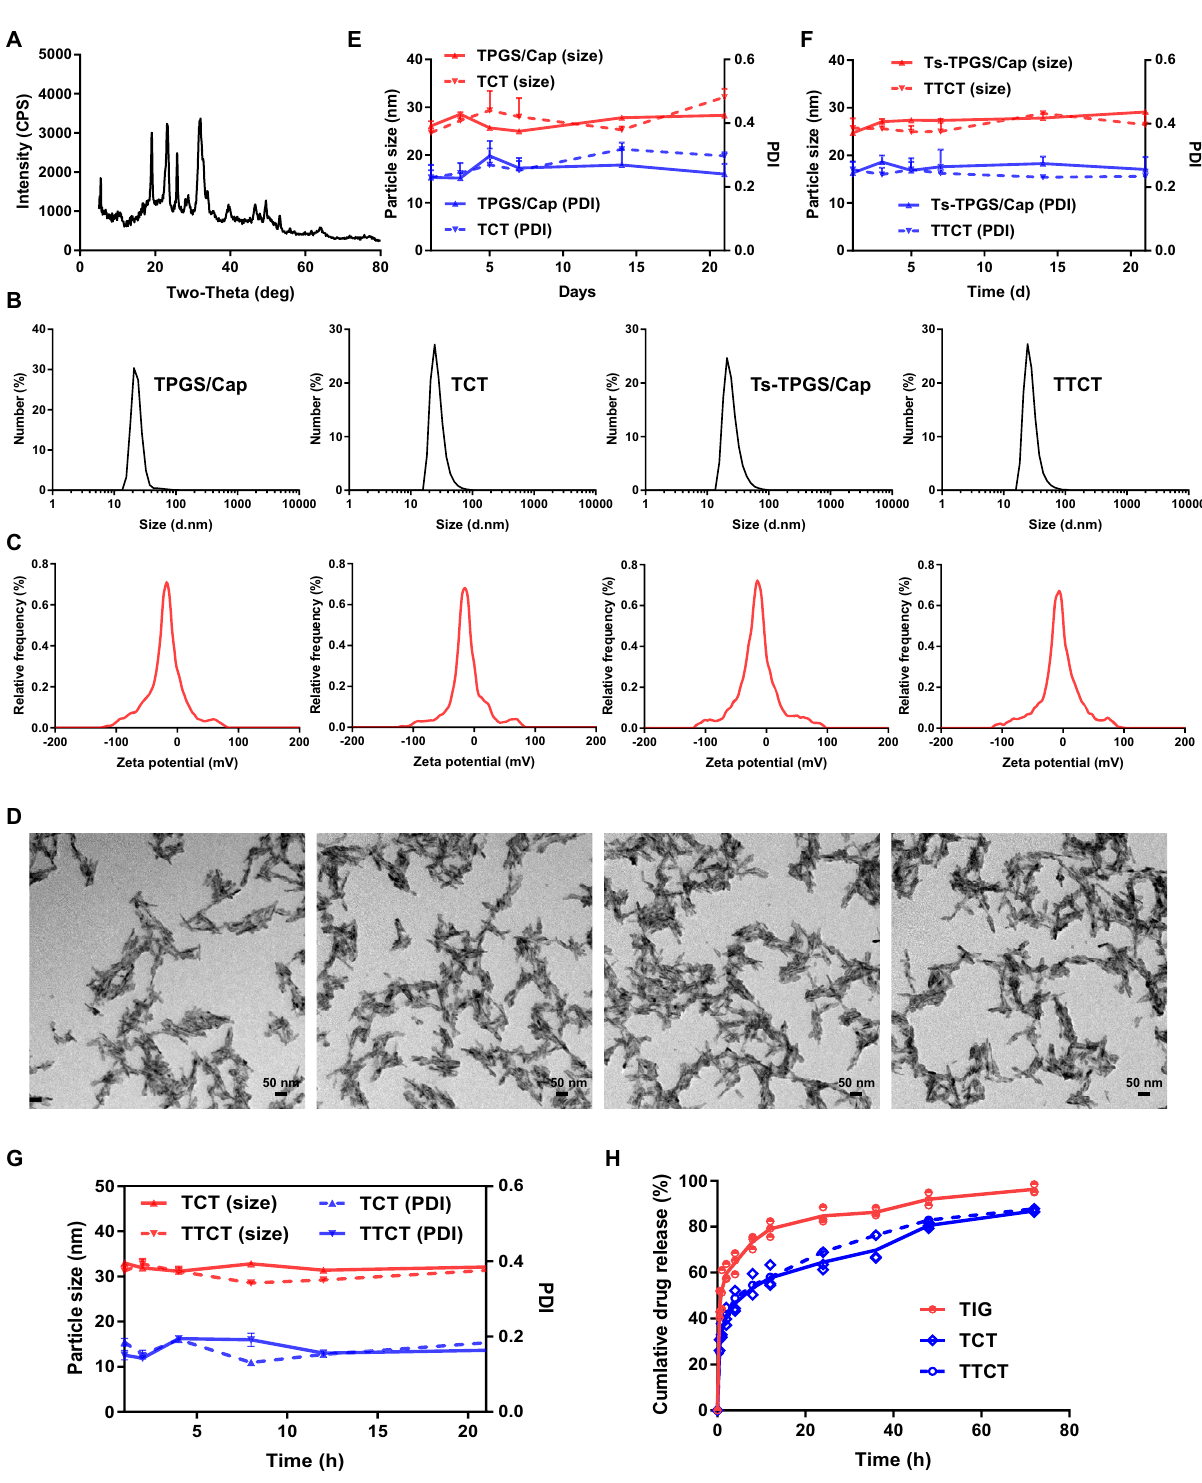
Fig. 3 Preparation and characterization of TTCT. A X-ray diffraction of TPGS/Cap nanorods. B Size distribution measured by DLS, C zeta potential distribution, and D representative TEM images of TPGS/Cap, Ts-TPGS/Cap, TCT, and TTCT (Scale bar = 50 nm). Particle size and PDI changes of E TPGS/Cap, Ts-TPGS/Cap, ( F ) TCT, and TTCT during 1 week of storage (n = 3 independent experiments). G Changes in particle size and PDI of TCT and TTCT in 10% fetal bovine serum (FBS)-containing PBS ( n = 3 independent experiments). H In vitro drug release pro fi les of TCT and TTCT in 10% fetal bovine serum (FBS)-containing PBS at pH 7.4 and 37 °C ( n = 3 independent experiments). TIG free tigecycline, TPGS/Cap TPGS-functionalized calcium phosphate nanorods, TCT tigecycline loaded TPGS/Cap nanorods, TTCT tigecycline-loaded Ts-TPGS/Cap nanorods. Data are expressed as the mean ± SD, and the mean value is the average of three independent experiments. The experiments in B – D were repeated independently for three times with similar results. Source data are provided as a Source Data fi